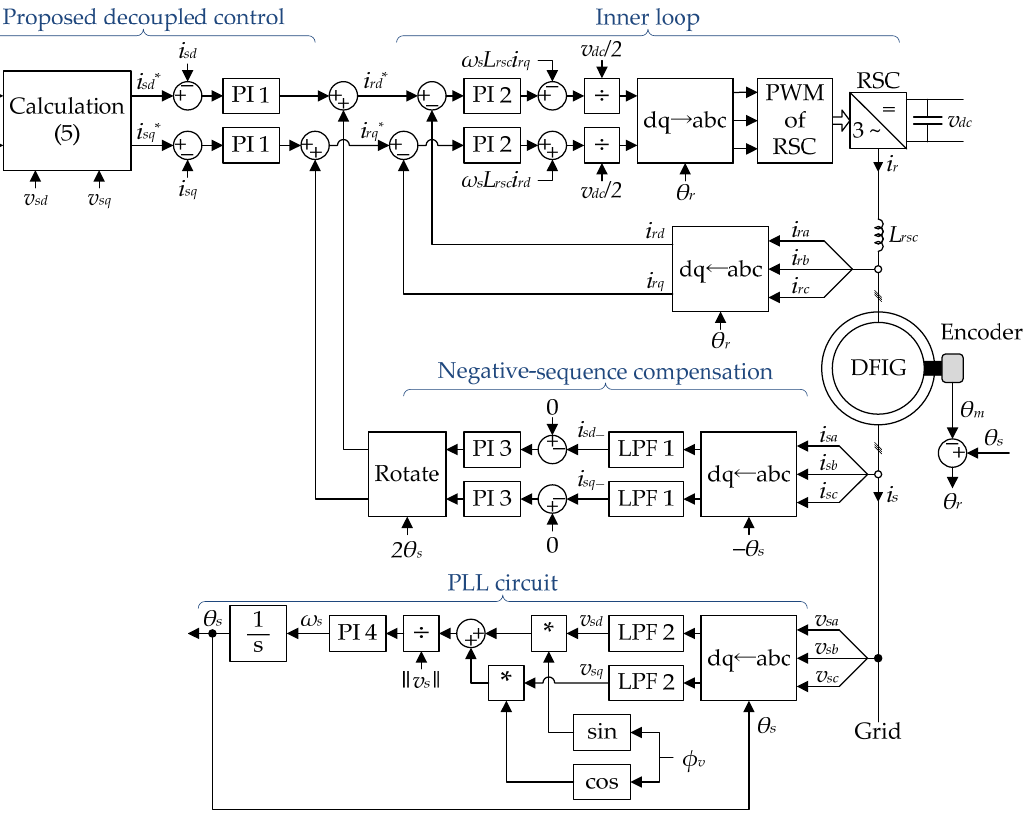
Figure 10. Block diagram of the control circuit for the rotor side converter (RSC) of the grid ‐ connected DFIG.